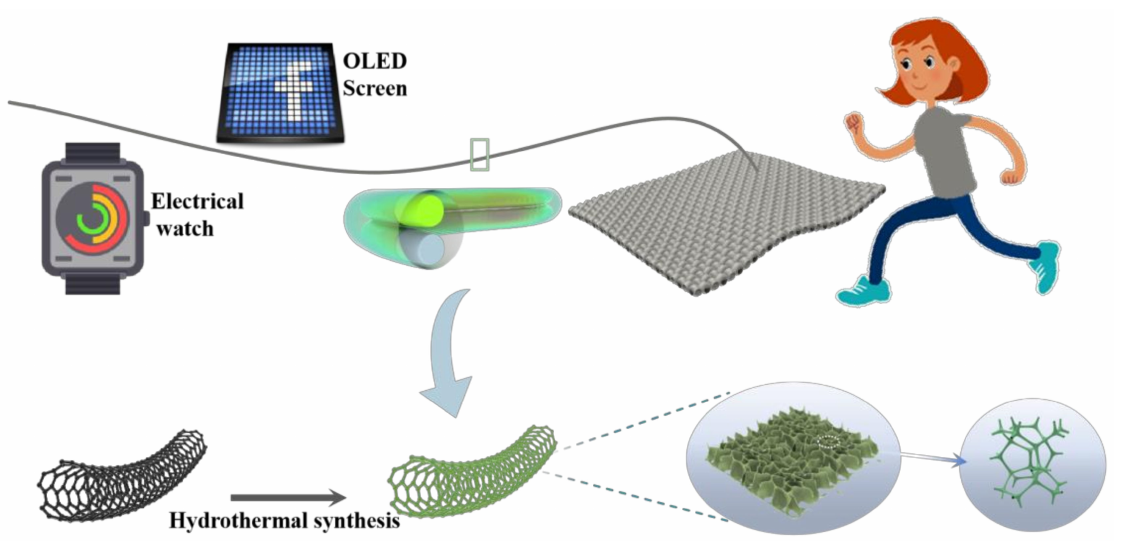
Figure 1. Schematic illustration of the NH 4 V 4 O 10 @CNT electrode and the flexible energy storage